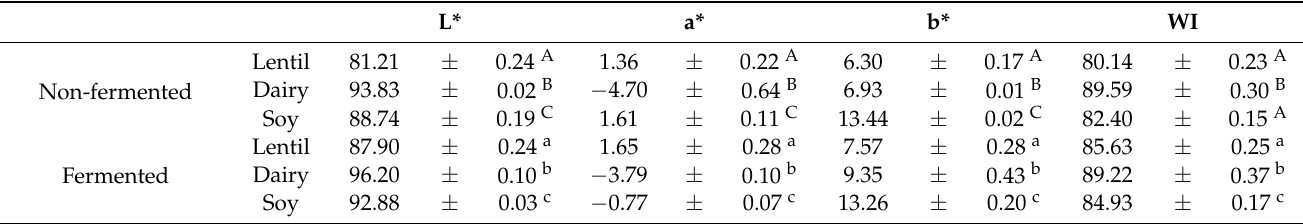
Table 3. Colour of the fermented samples, using the CIE L*a*b* colour space, with L* representing lightness (0 = black, 100 = white); a* showing green ( − 500) to red (+500); b* ranging from blue ( − 200) to yellow (+200); and whiteness index (WI). Values within a column of the fermented (lowercase letters) or unfermented product (capital letters) with different superscript letters are significantly different ( p ≤